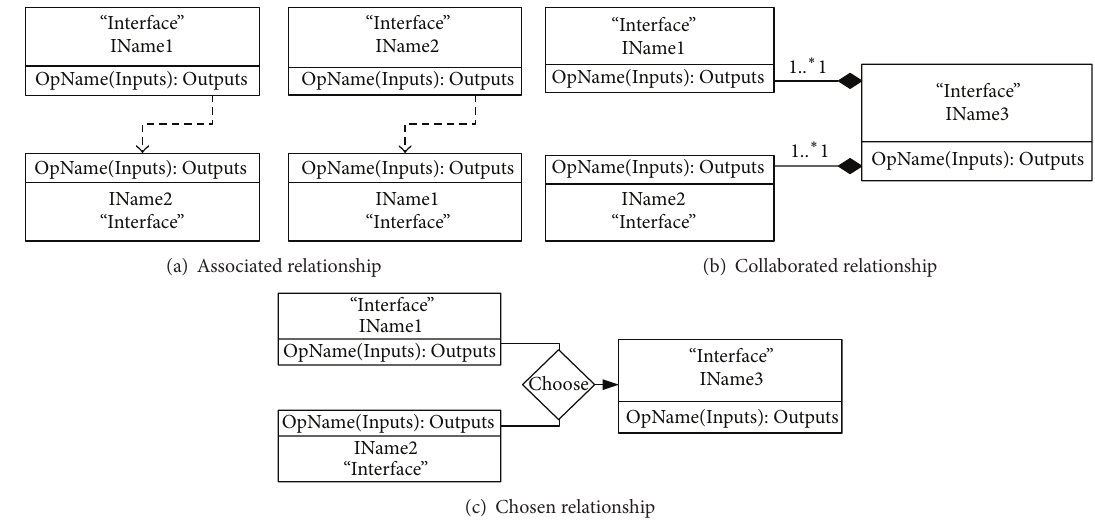
Figure 6: Basic composition relationships between two interfaces.